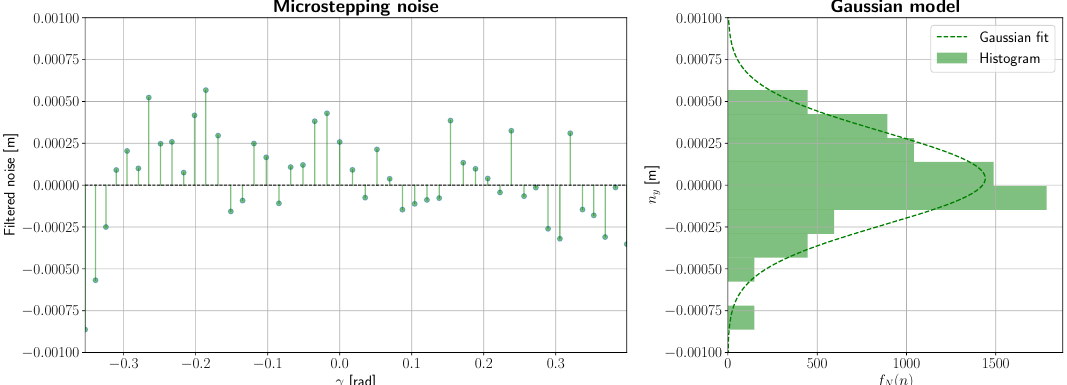
Figure 8. Image noise due to